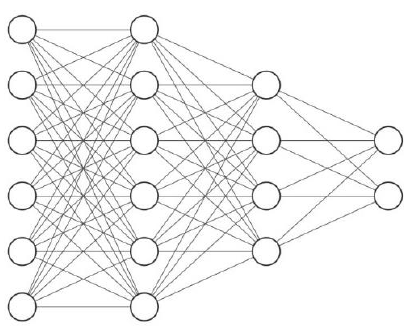
Figure 17. The topology of a feed-forward with two hidden (6-6-4-2). To optimize the ANN's weights and biases, the FOA has been used to provide the least prediction error for trained structure. The properties of the FOA parameters are shown in Table 6. Table 6. Properties of FOA parameters.